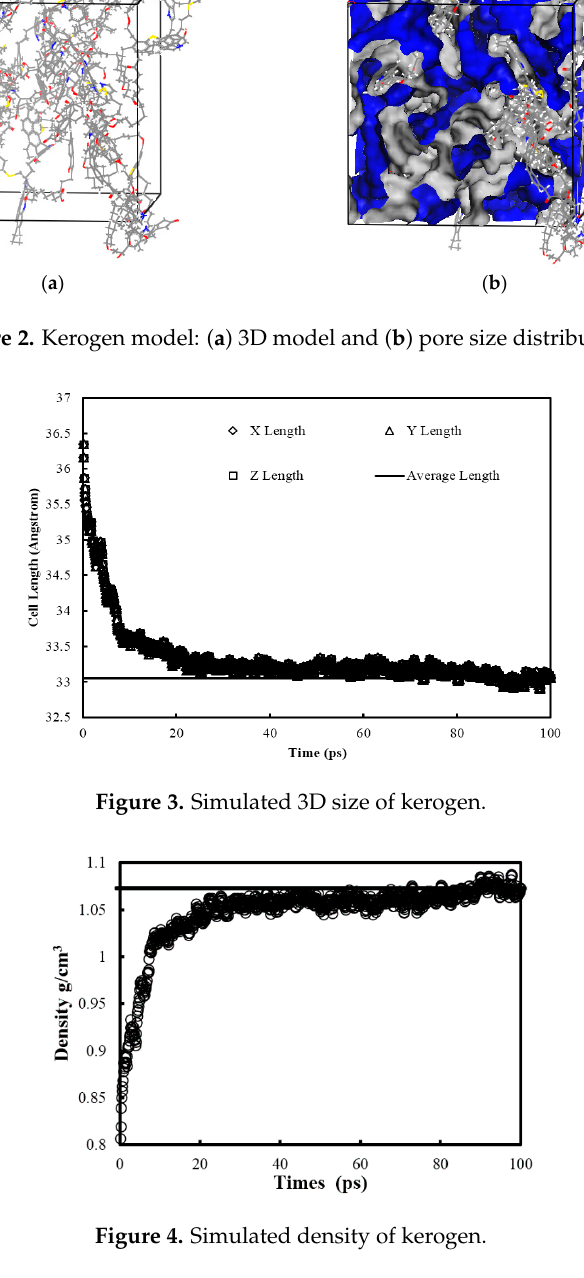
Figure 4. Simulated density of kerogen.